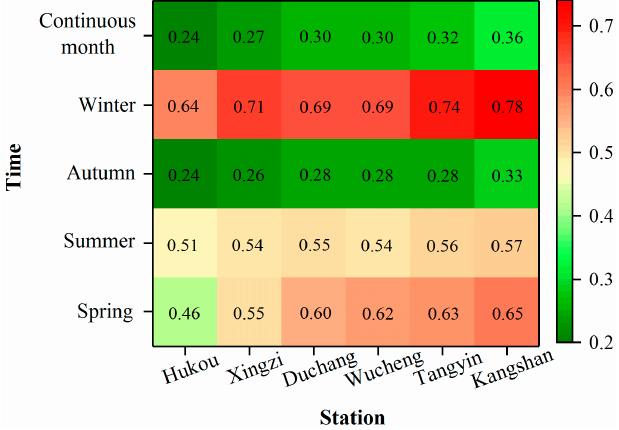
Figure 13. Spatial distribution of the correlations between the lake level at each gauging station and the SPEI values at a 3-month timescale.